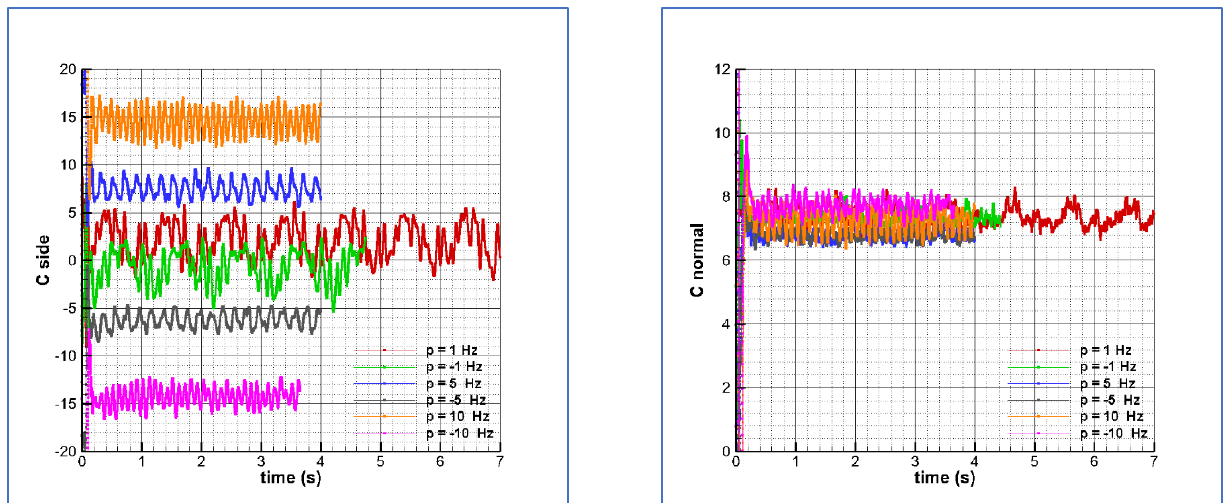
Figure 2. Side ( left ) and normal ( right ) force coefficient versus time at Ma = 0.2, Re =2 × 10 6 and α = 45 deg.